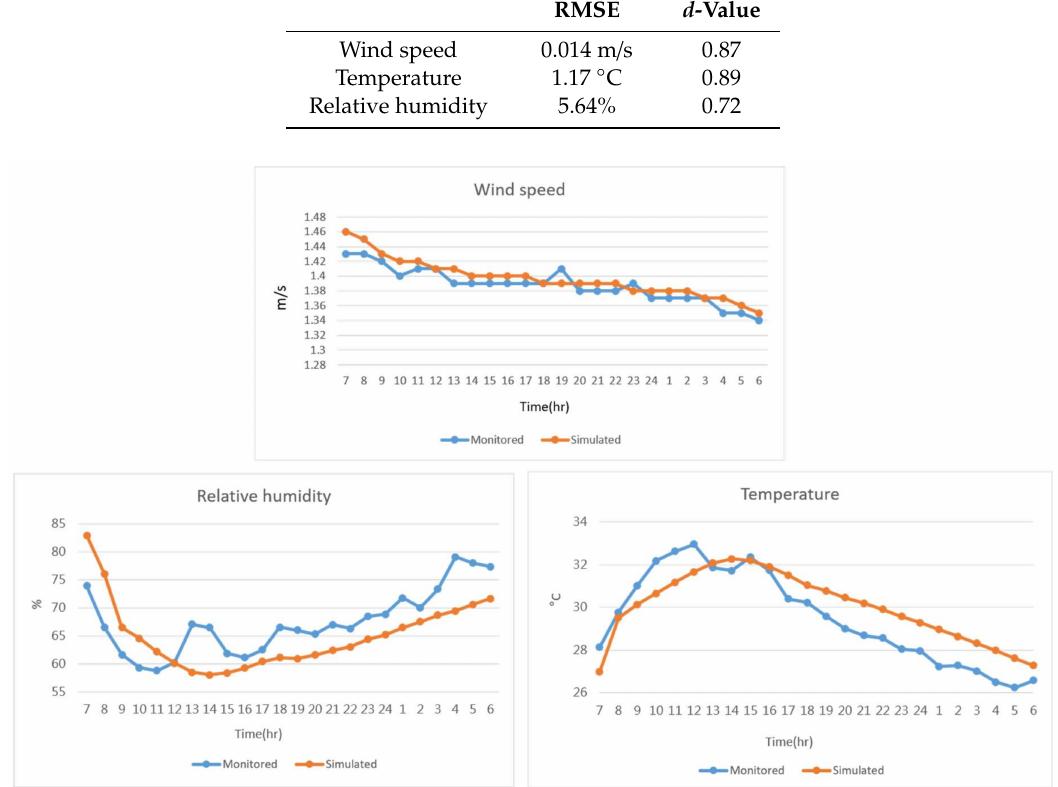
Figure 6. Time series of validation